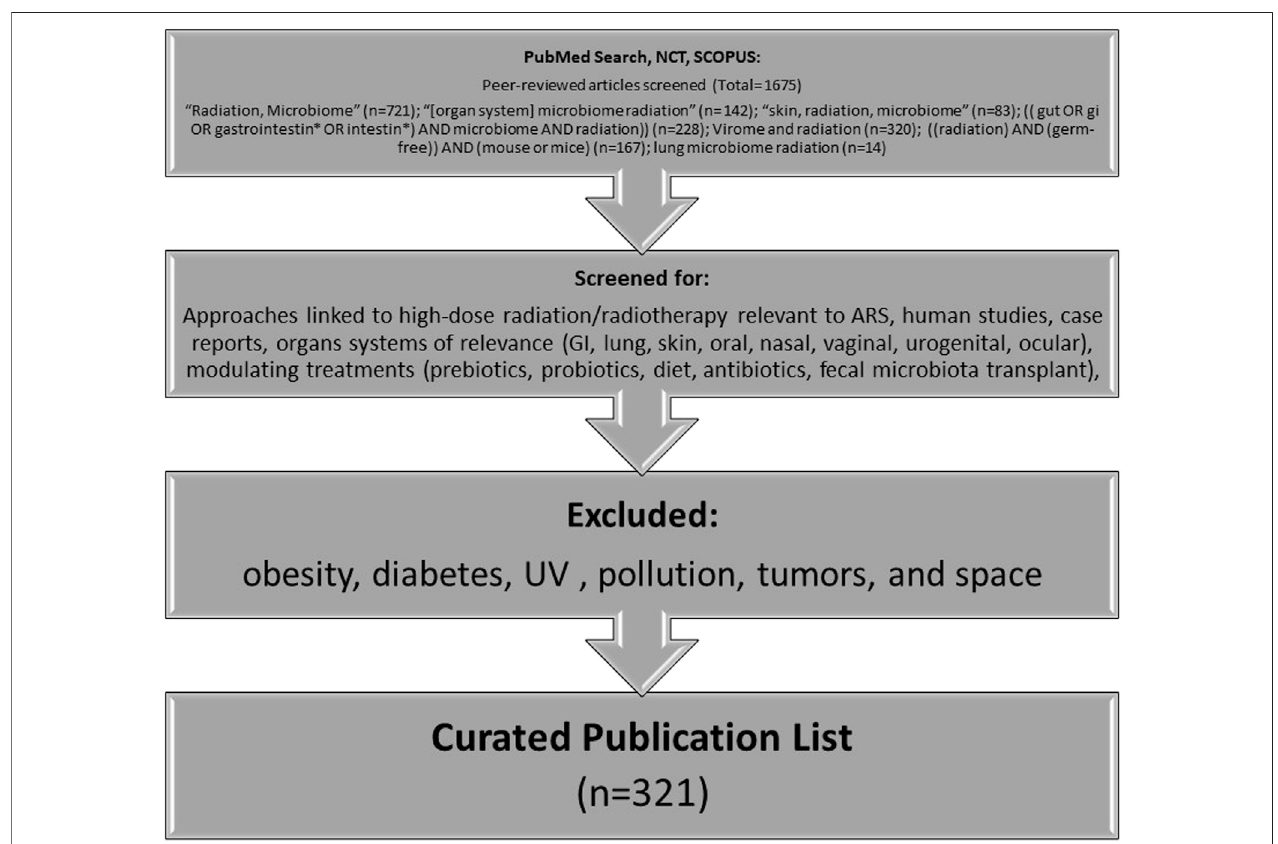
FIGURE 2 | Methodology for curation of literature for this review (*NCT: clinicaltrials.gov).